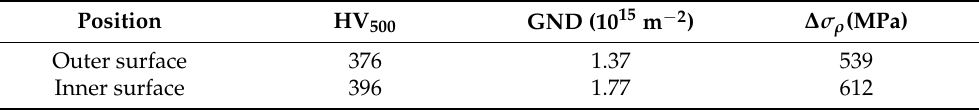
Table 8. The HV, GND and dislocation strengthening of the forged tube with a reduction of 48.7%. Position HV 500 GND (10 15 m − 2 ) Outer surface 376 Inner